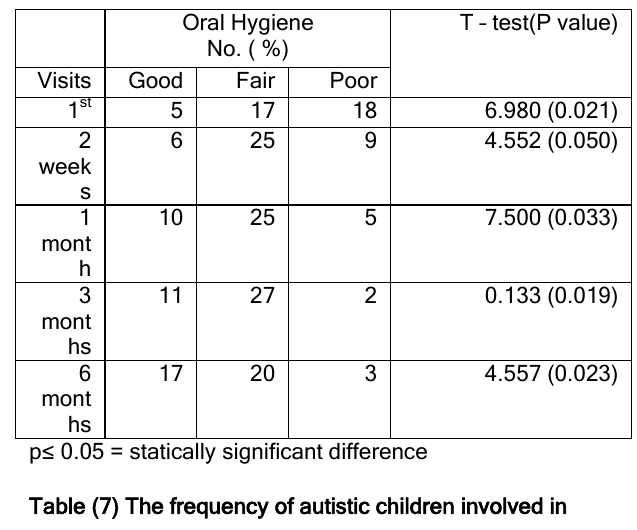
Table (7) The frequency of autistic children involved in different non pharmacological l and pharmacological behavior management methods.